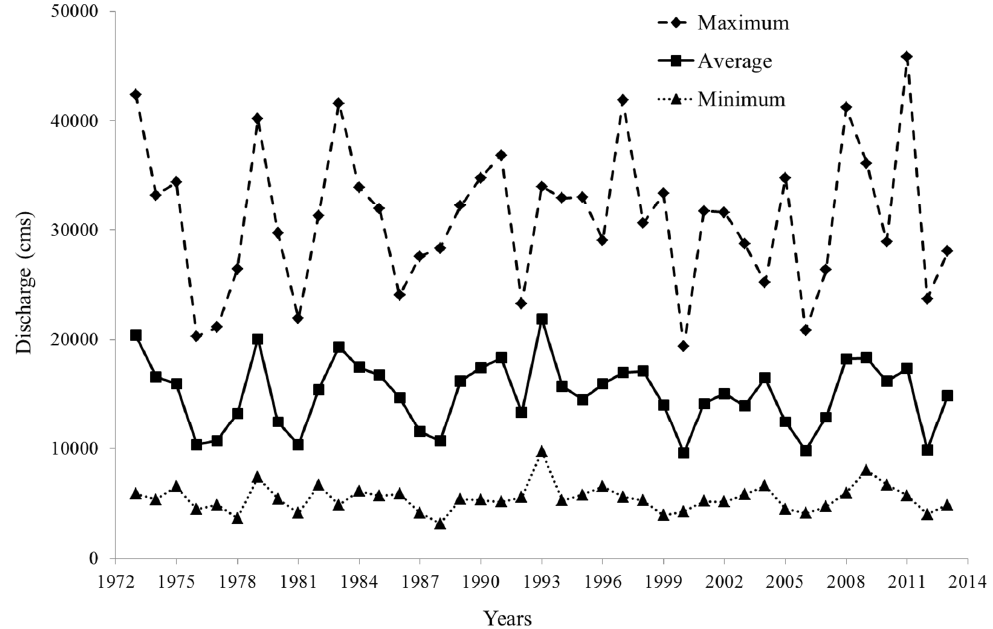
Figure 6. Annual mean, maximum, and minimum of daily discharge at Tarbert Landing of the LmMR.